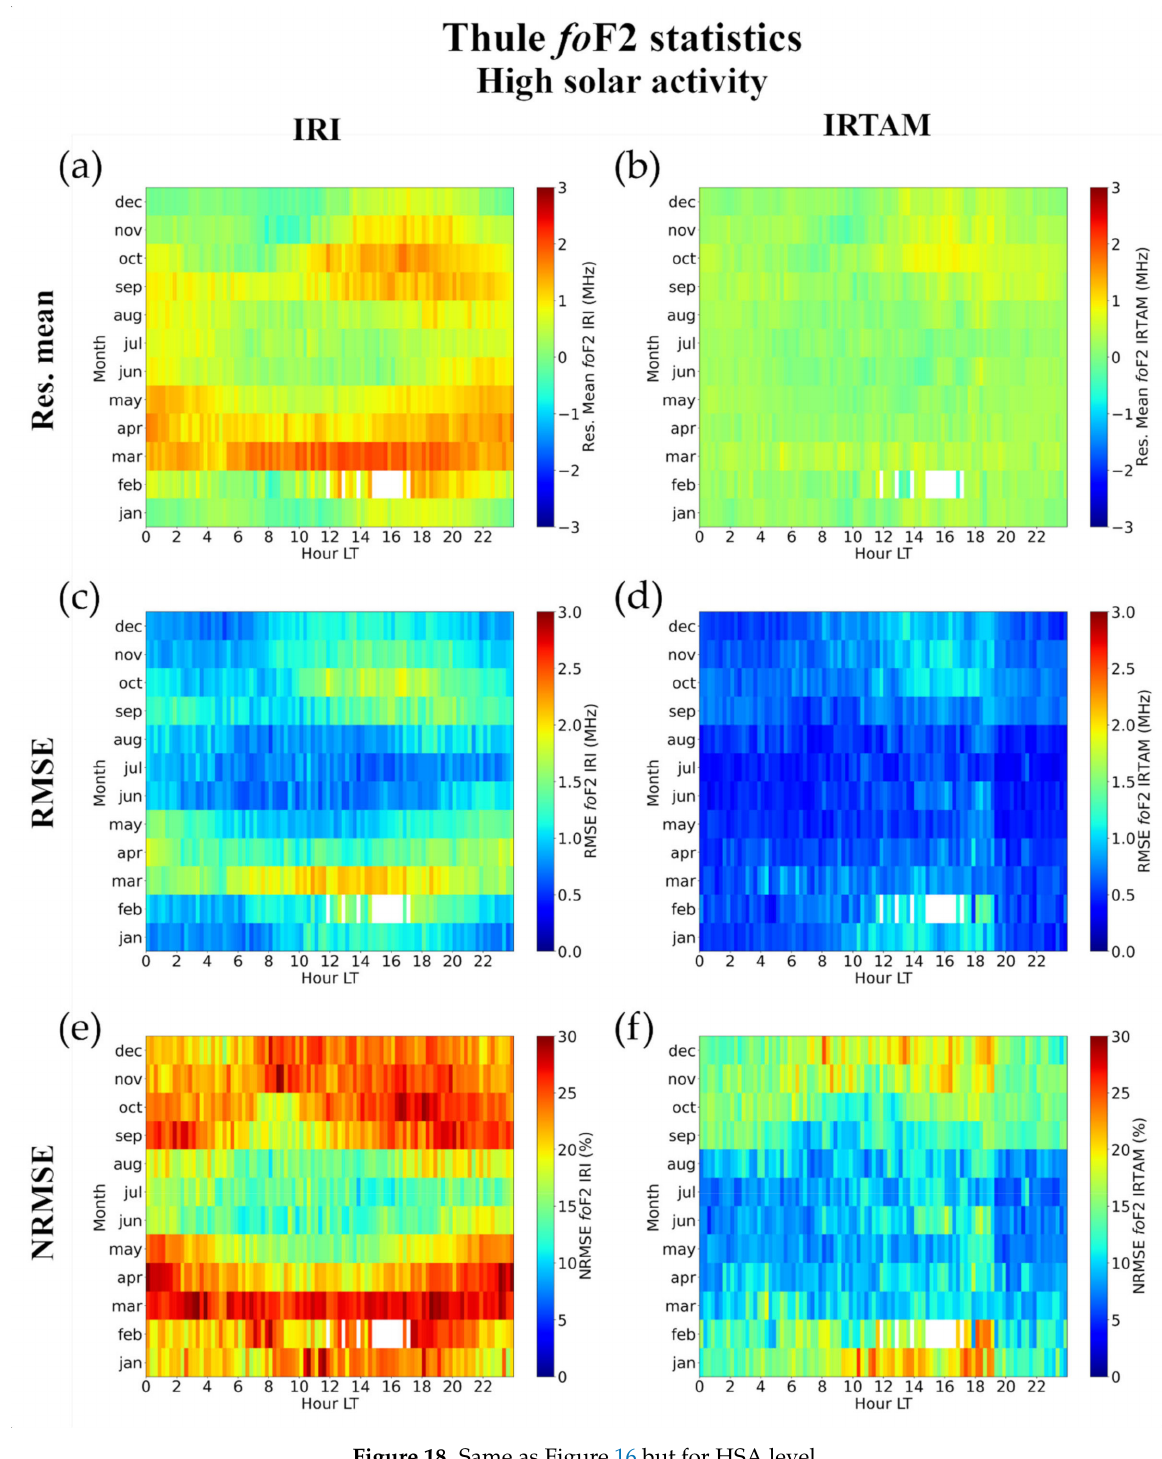
Figure 18. Same as Figure 16 but for HSA